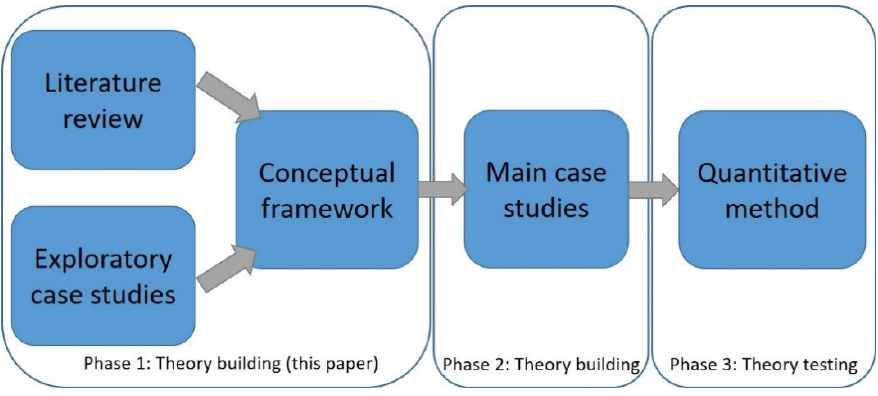
Figure 2. Research process.